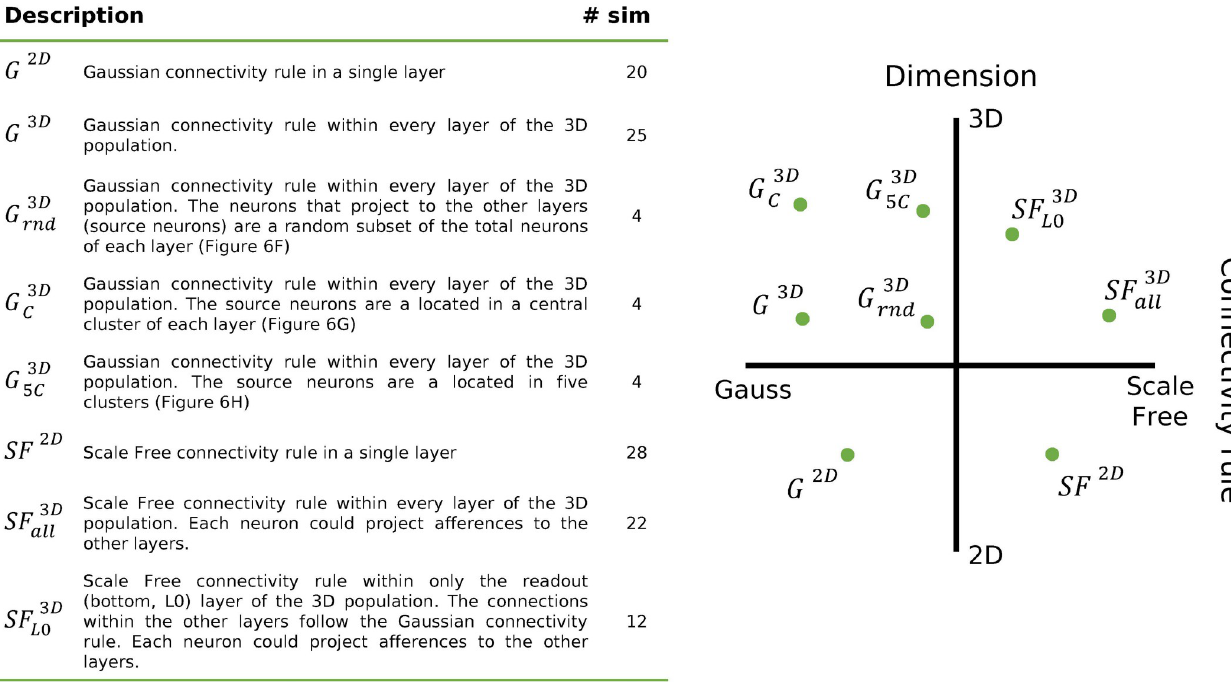
Fig 1. Representation of the dataset. All the configurations analyzed in the paper are reported here with their abbreviation and a brief description. For all the 3D, the connectivity among the layers (inter-layer connections) follows a Gaussian distribution scaled over distance as reported in Sect 3D connectivity.